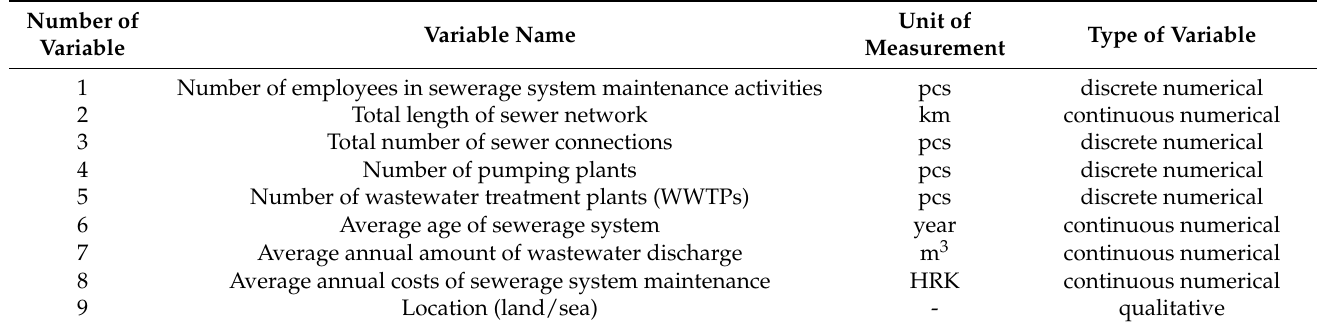
Table 4. List of possible independent variables in model for estimating maintenance costs of the sewerage